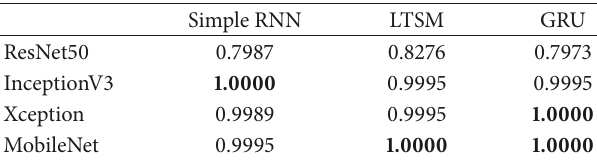
Table 2: 10-fold test mean accuracy with different CNN and RNN